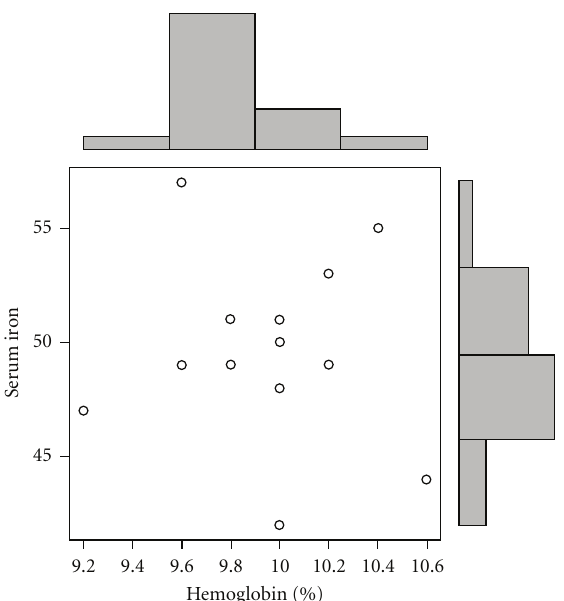
Figure 7: Pearson’s correlation coe ffi cient graph of hemoglobin (%) levels and serum iron levels in OSMF stage II showing a significant correlation (correlation value: −